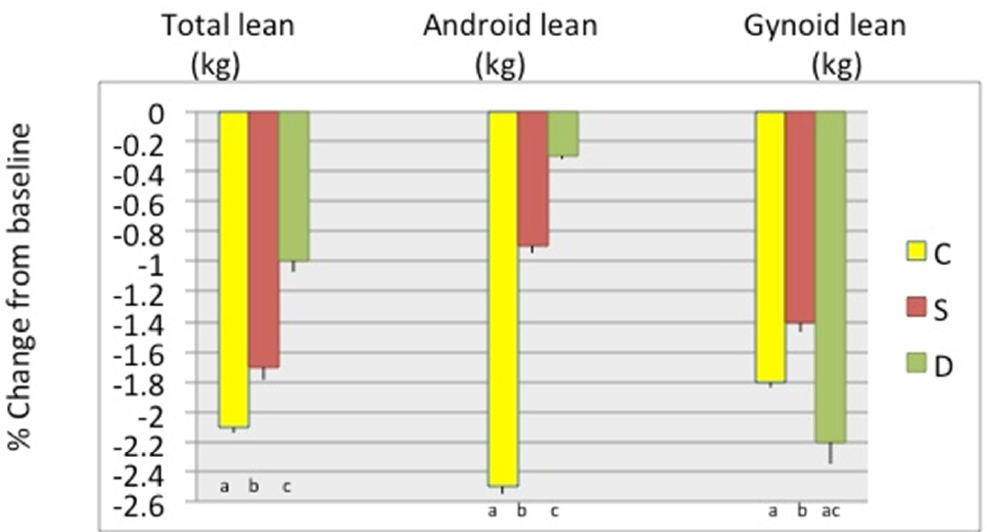
Figure 4. Percent change (mean ± SEM) in total body lean mass, android lean and gynoid lean (all kg), respectively, between baseline and 6-month among the groups. Only the complete data sets at baseline and 6 months were used: C-Control / placebo, n = 30; S-Supplement, n = 37; D-Dairy, n = 30. Bars with di ff erent letters indicate the statistically significant di ff erence among the groups at 6